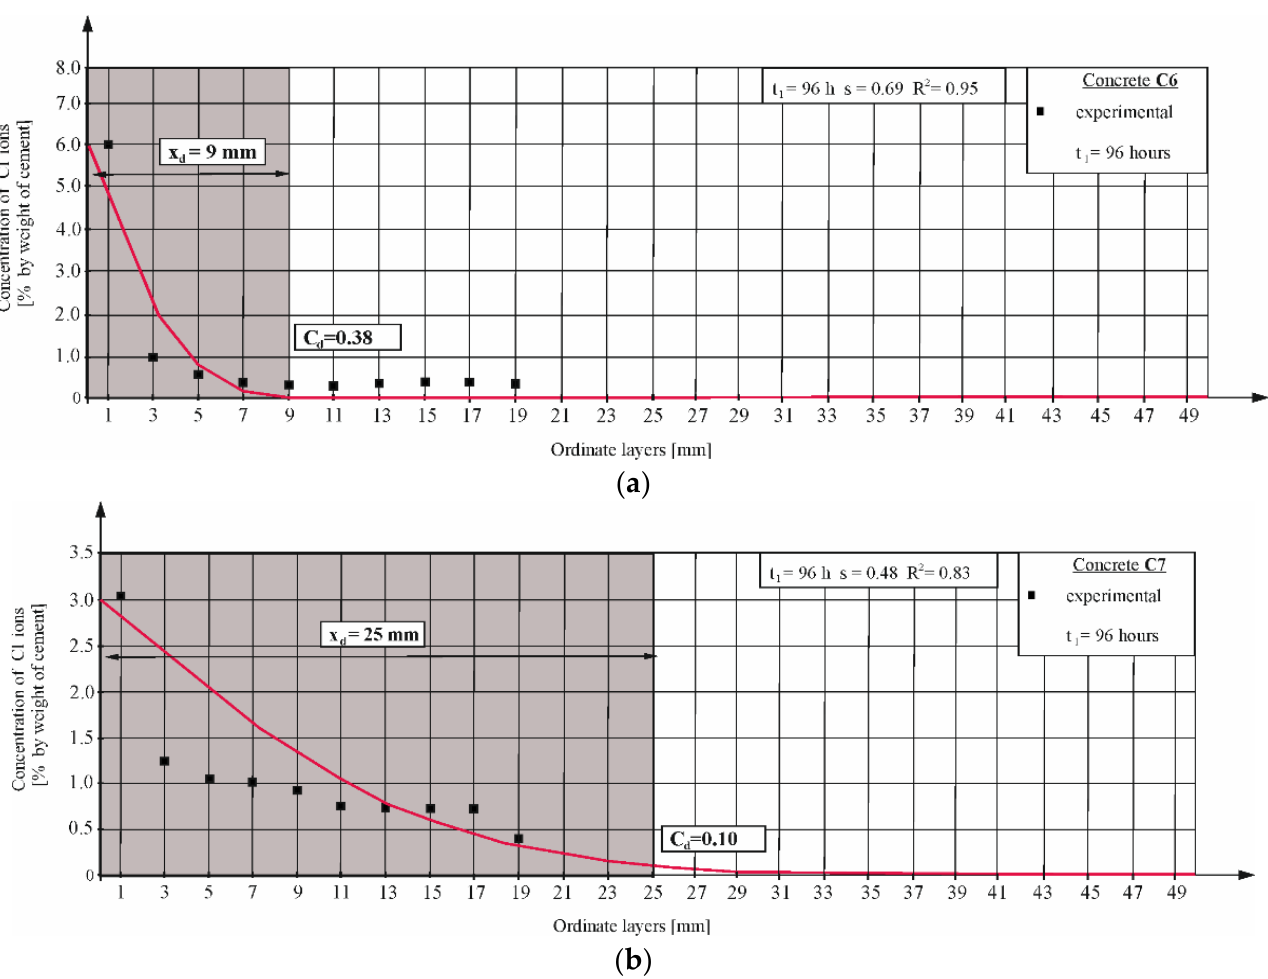
Figure 5. Chloride ion profile determined in migration tests according to NT BUILD 492 [14] and calculated using the Equation (5) in concretes: ( a ) C6; ( b ) C7.